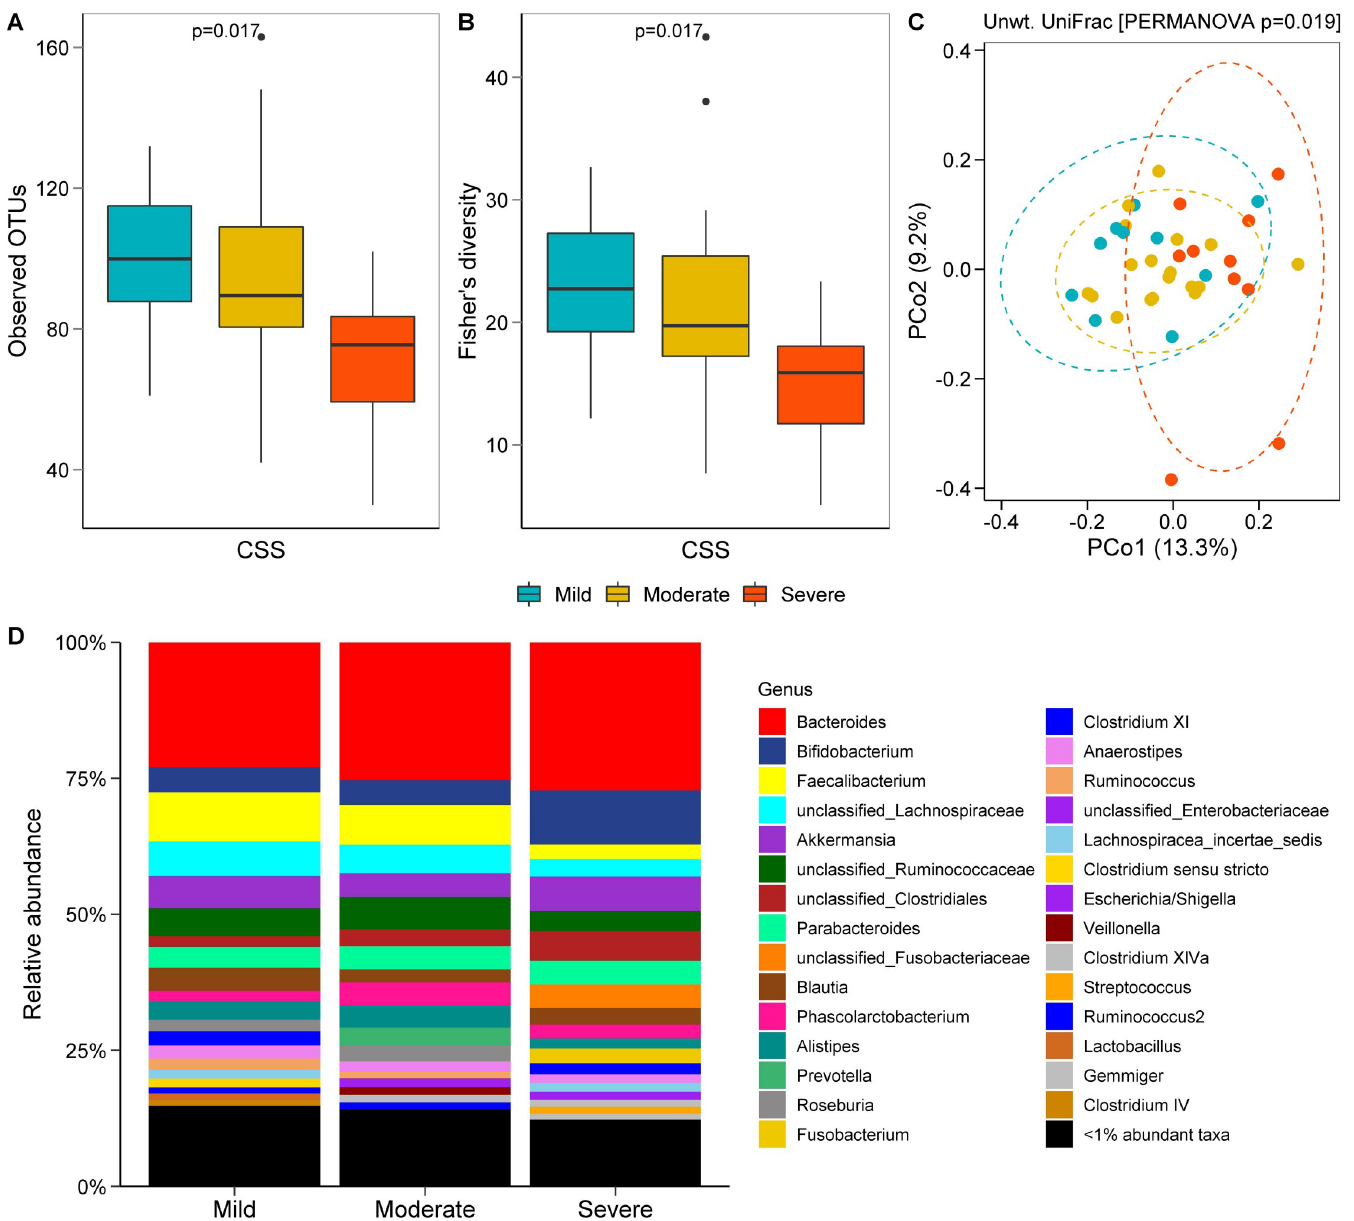
Fig 3. Gut bacterial richness, diversity, and composition in individuals with Rett syndrome (RTT) by Clinical Severity Score (CSS). Number of observed OTUs ( A ) and Fisher’s alpha index of diversity ( B ) by CSS. PCoA plot of unweighted UniFrac distance ( C ) based on CSS groups. Relative abundance (%) of bacterial taxa at the genus level ( D ) in the RTT cohort grouped by CSS. Mild (CSS � 19, n = 10), moderate (CSS = 20–30, n = 18) and severe (CSS � 31, n =